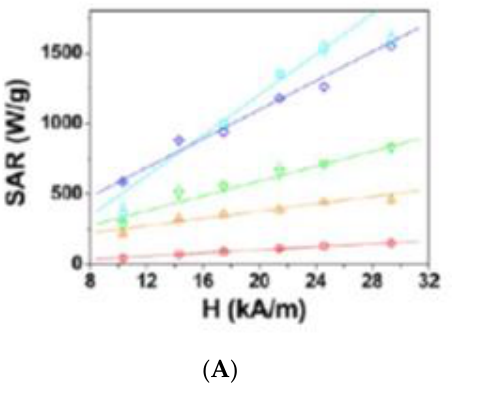
Figure 27. ( a ) Magnetic field dependence in Langevin units of the MMC magnetic moment for four values of the anisotropy constant. ( b ) Magnetic field dependence of MMC susceptibility: experiment and theoretical fit (Reprinted figure from [ Error! Reference source not found. ]. Copyright 2020 by the American Physical Society), ( c ) Magnetic field amplitude dependence of the magnetic dipole–dipole interaction parameter, and ( d ) MMC surface separation dependence of van der Waals and magnetic dipole–dipole energies. (Reprinted from [ Error! Reference source not found. ], Copyright 2020, with permission from Elsevier).